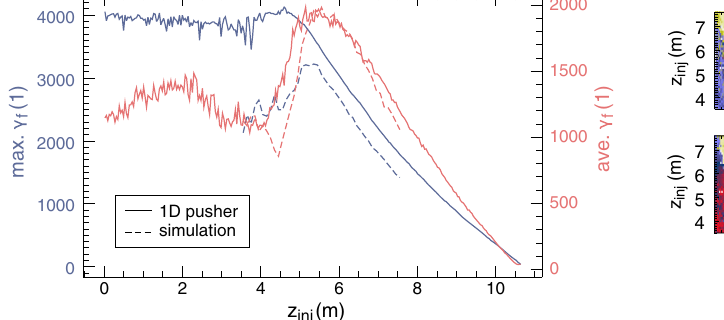
FIG. 11. (a) Radial average and (b) – (d) peak final energies of injected electrons as a function of their initial longitudinal position ξ 0 and their injection point z , as obtained from the inj PIC simulation. The peak energies are shown for (b) all initial , and (d) for r 0 > 1 . 5 k − 1 radii r 0 , (c) for r 0 < 1 . 5 k − 1 pe pe